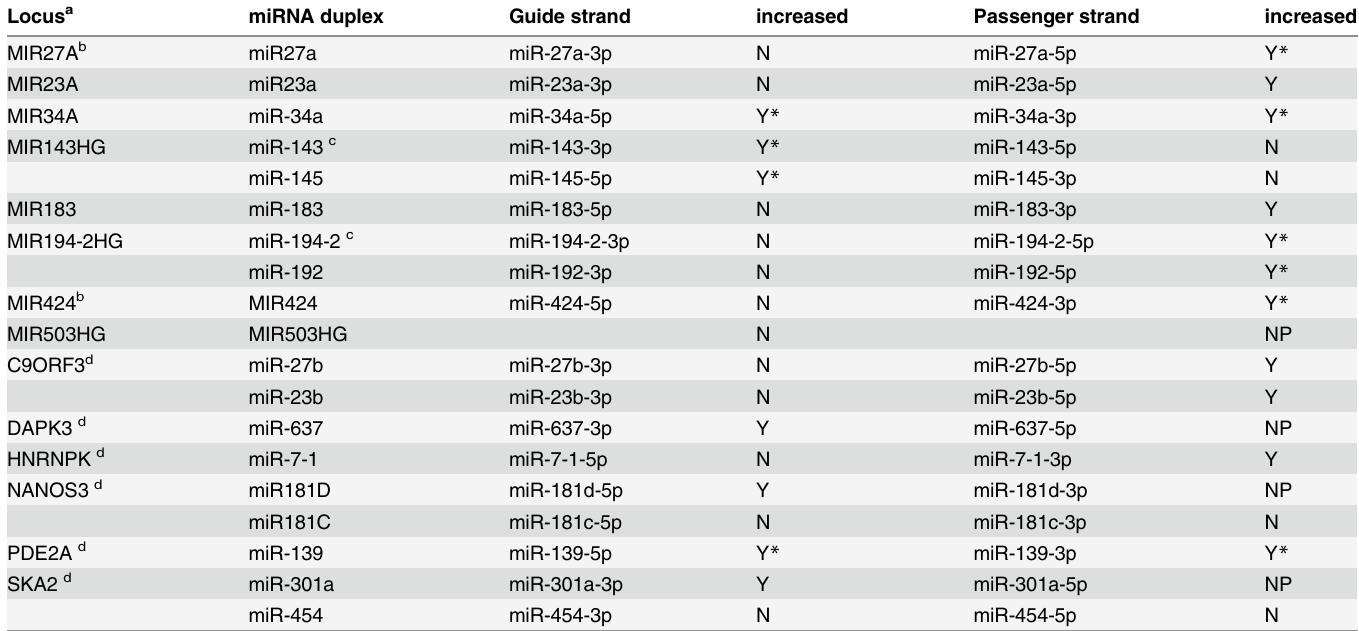
Table 1. List of miRNAs induced at the permissive temperature grouped by locus. Locus a Guide strand